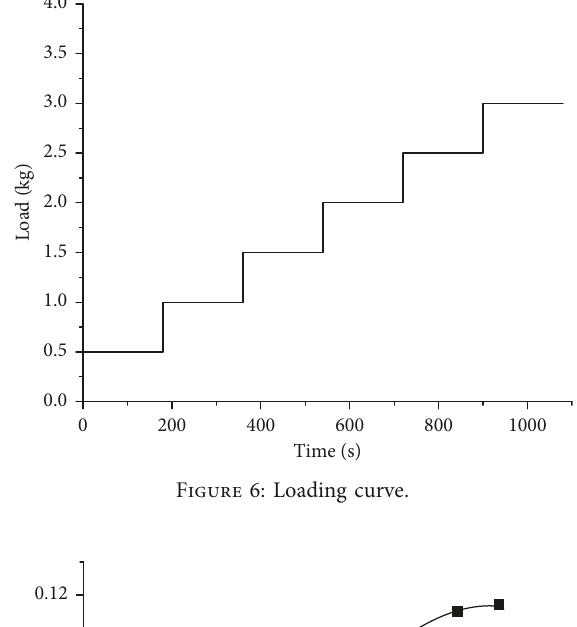
Figure 6: Loading curve.